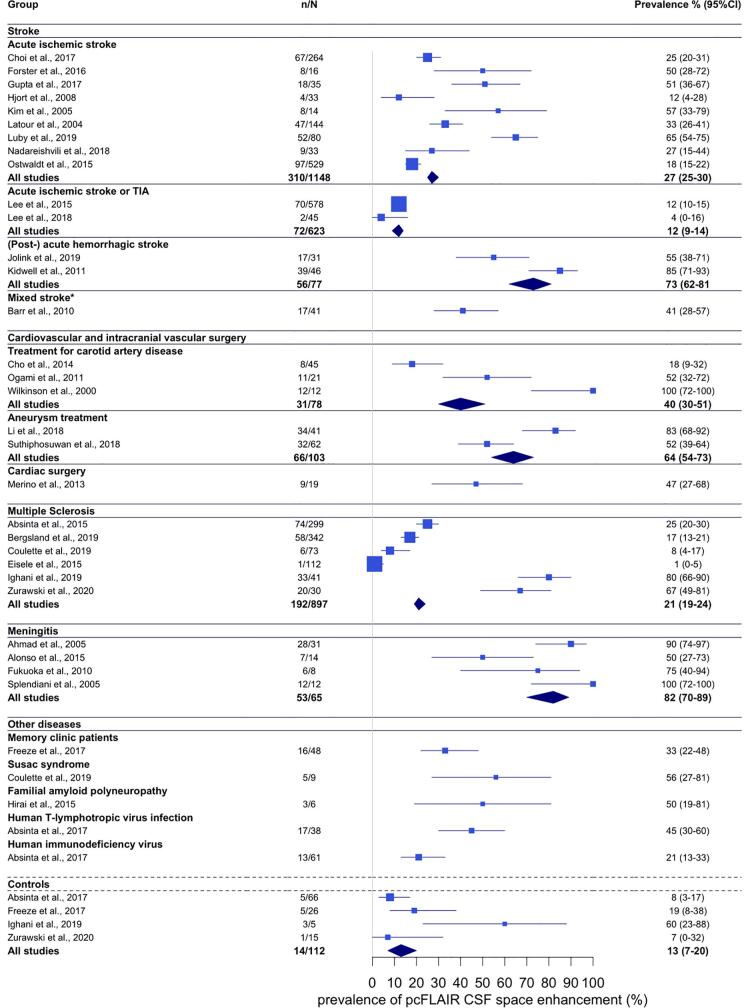
The prevalence of pcT2wFLAIR CSF enhancement across disease groups. Point estimates are represented by squares for individual studies, and diamonds for summed disease categories. The area of each point estimate is proportional to the size of each study. The error bars represent 95% confidence intervals. N = sample size, n = number of cases with pcT2wFLAIR CSF enhancement. * Study sample included both cases with ischemic stroke as well as cases with intracerebral hemorrhage.